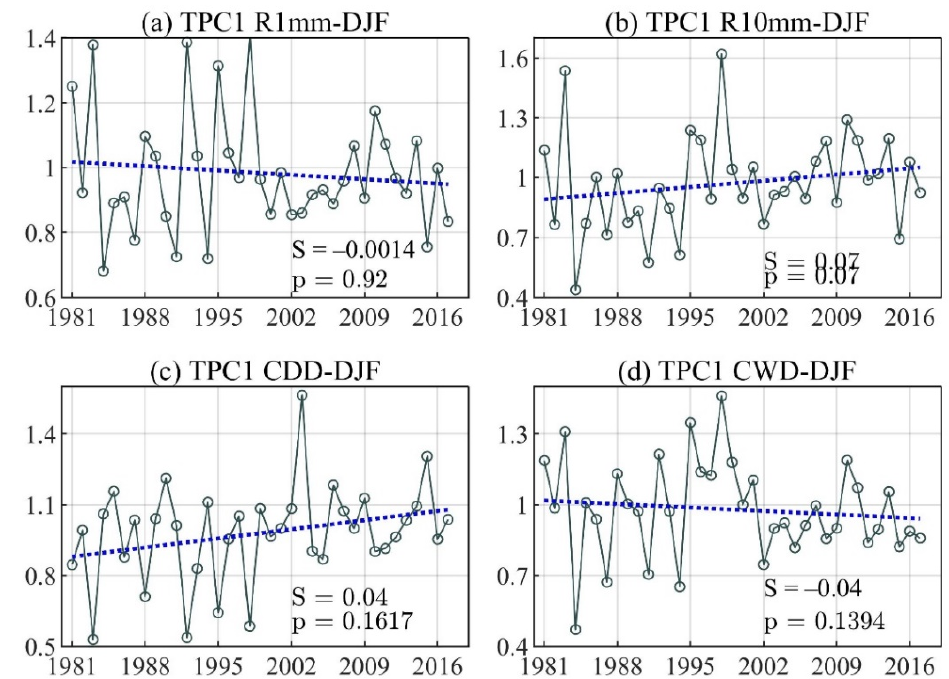
Figure A2. The linear trend of the principal component time series for the first trend mode-EOF of Max 1-day precipitation amount (RX1day) during ( a ) December–February (DJF), (b) March–May (MAM), ( c ) June–August (JJA), and ( d ) September–November (SON).